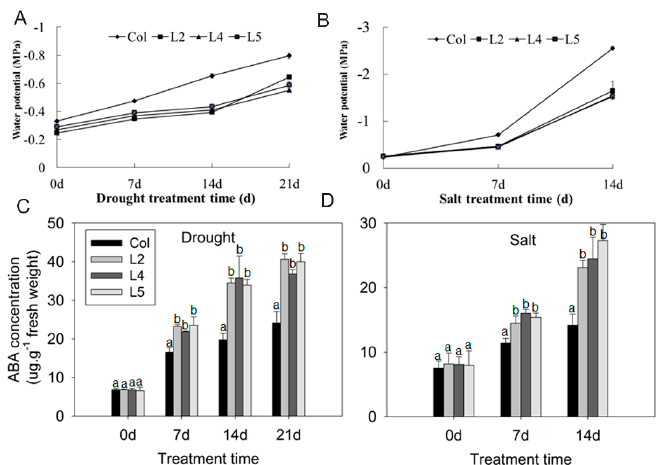
Figure 5. Water potential and ABA content of SpCIPK26 -OXP and WT suffered from drought and salt treatment: ( A , B ) water potential of transgenic and WT plants at different drought and salt treatment time; and ( C , D ) stand results of ABA concentration of plant leaves stressed by drought and salt for different time. Drought was carried out by withholding water for indicated time, and salt was handled by irrigating 150 mM NaCl every day and samples were collected weekly. All treatments were replicated three times biologically. Error bar denotes standard deviation, and different letters above the bars signify significant difference between wild type (control, Col) and transgenic lines (L2, L4 and L5) at p < 0.01.